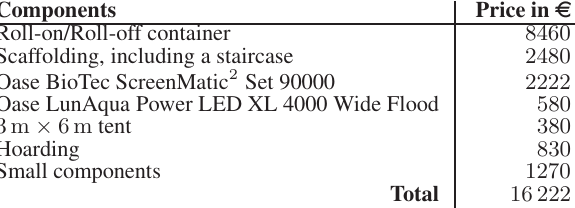
Table 1. List of used components and their prices. The small components includes wooden planks, screws, wire and similar.